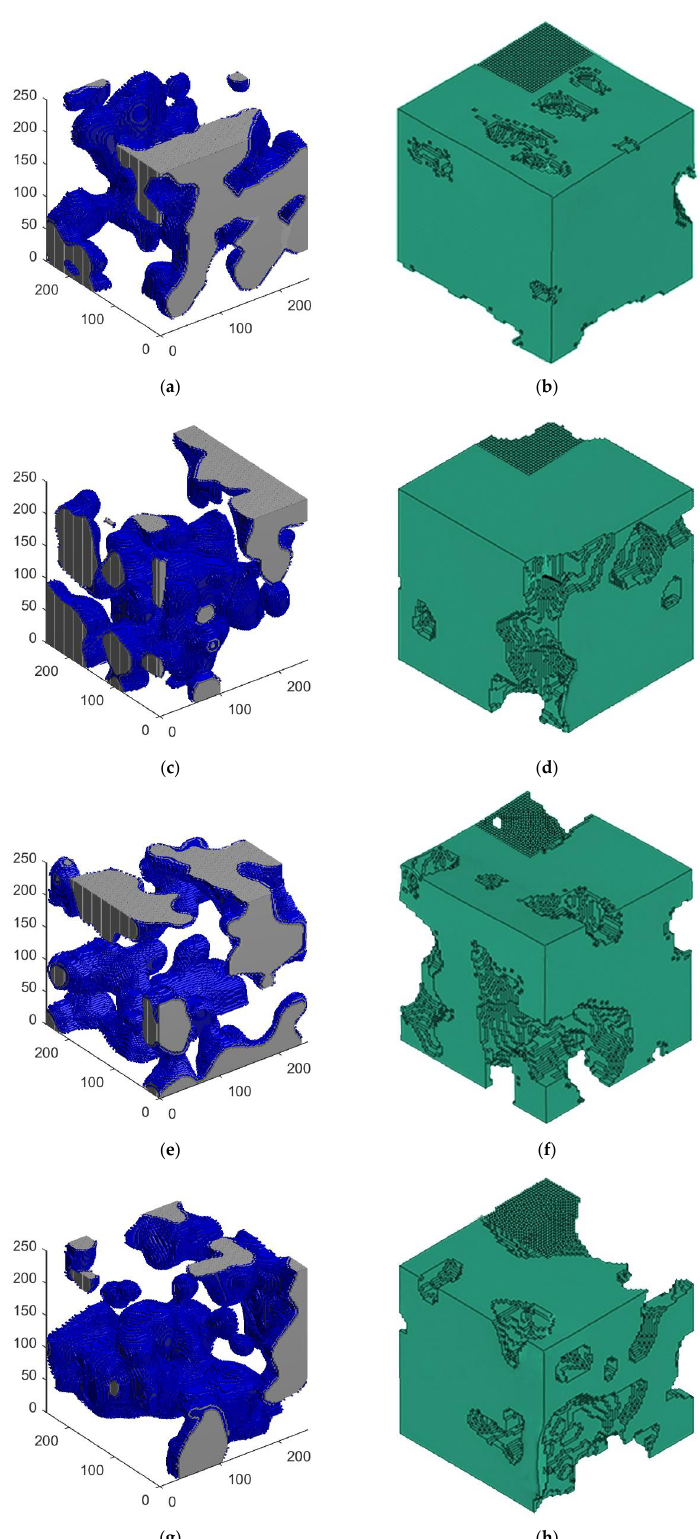
Figure 8. Reconstructed pore topological structures and 3D Finite Element Analysis (FEA) models with mesh in a small area corresponding to SEM images of micron silver sintered joints under different thermal shocks: ( a , b ) 50; ( c , d ) 150; ( e , f ) 150; ( g , h ) 250 cycles. In 3D views of the left column, gray represents defined geometric boundaries, and blue is the iso-surface. Normalized autocorrelation functions of SEM images and 3D reconstruction models are plotted in Figure 9, where the size of reconstructed models (250 pixels) is much larger than the observed correlation length of SEM samples (the autocorrelation function asymptotic location), illustrating reconstructed models can represent the microstructure of sintered joints. The KL divergence values are calculated and listed in Table 2, which are within an acceptable range (less than 15%). Both qualitative observation and quantitative calculation show that the reconstructed models are consistent with the original images.